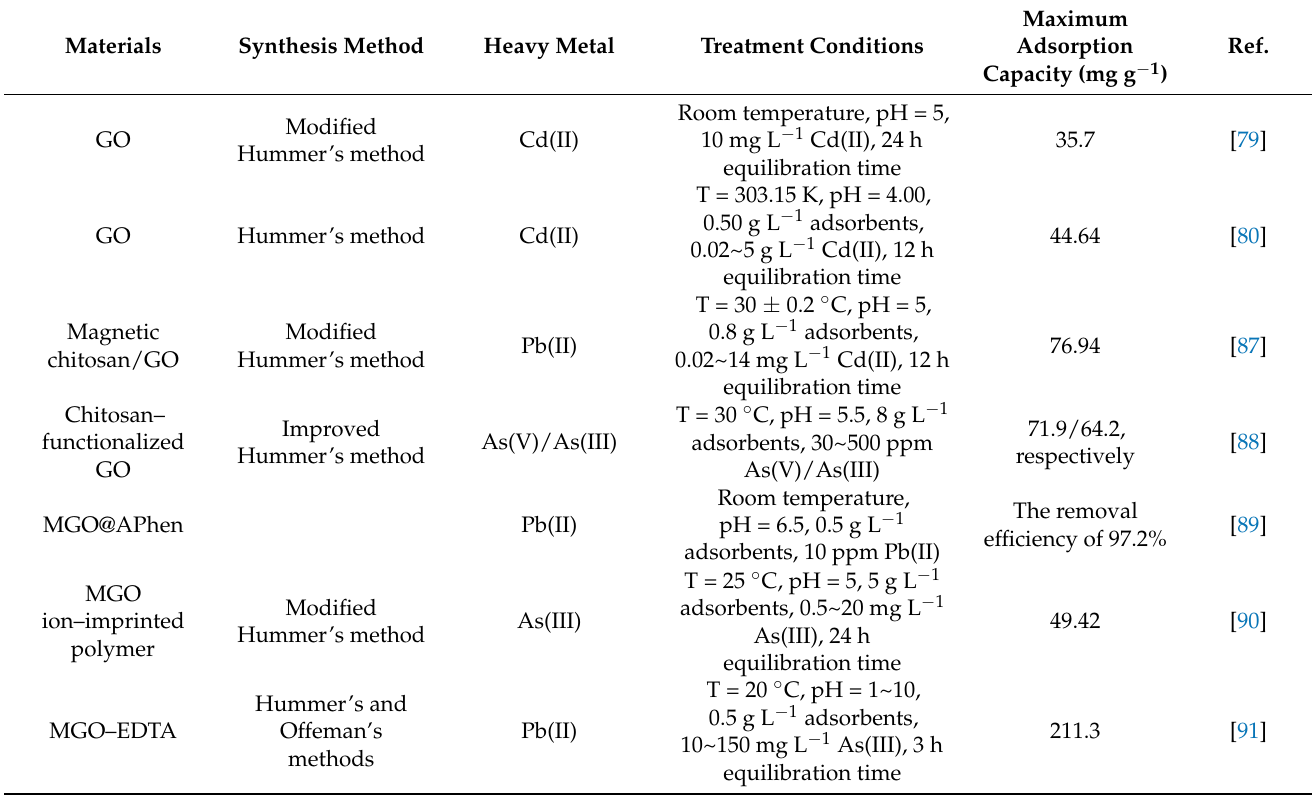
Table 1. Heavy metal adsorption capacity/removal efficiency, as reported in the